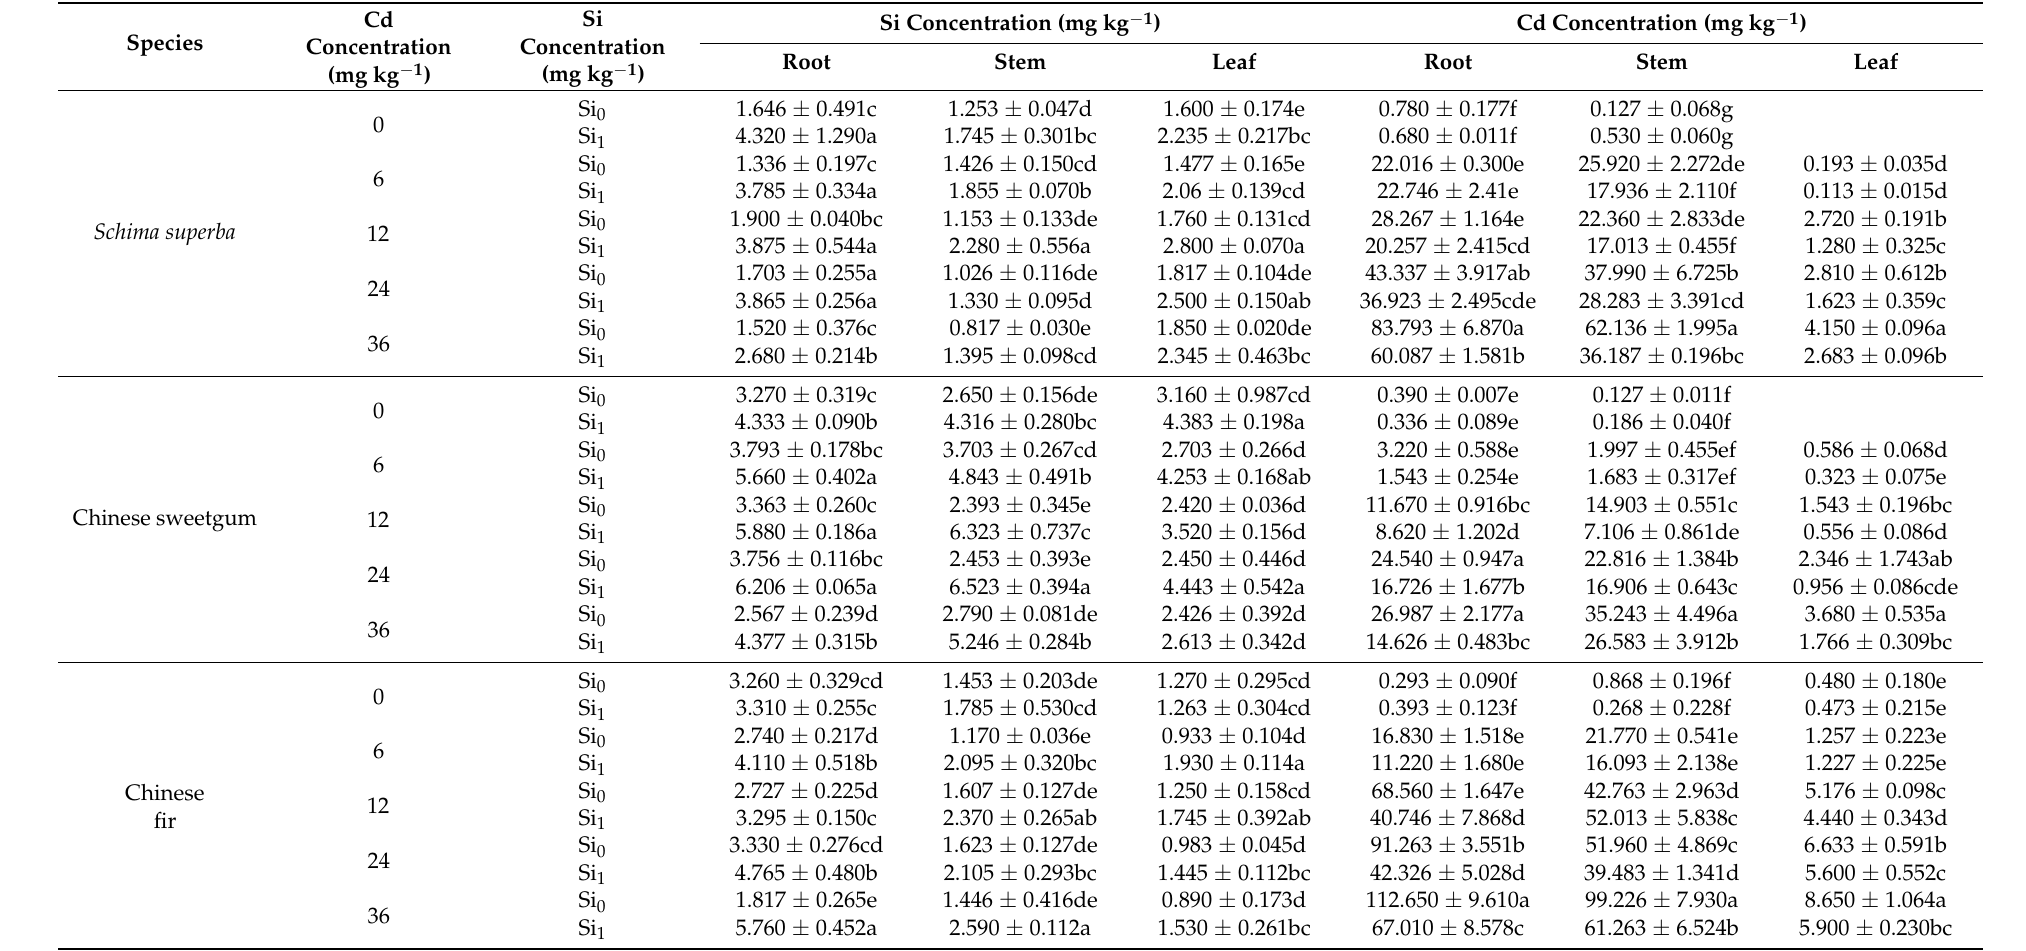
Table 2. Effects of Cd and Si on Cd and Si concentrations of different fractions of the